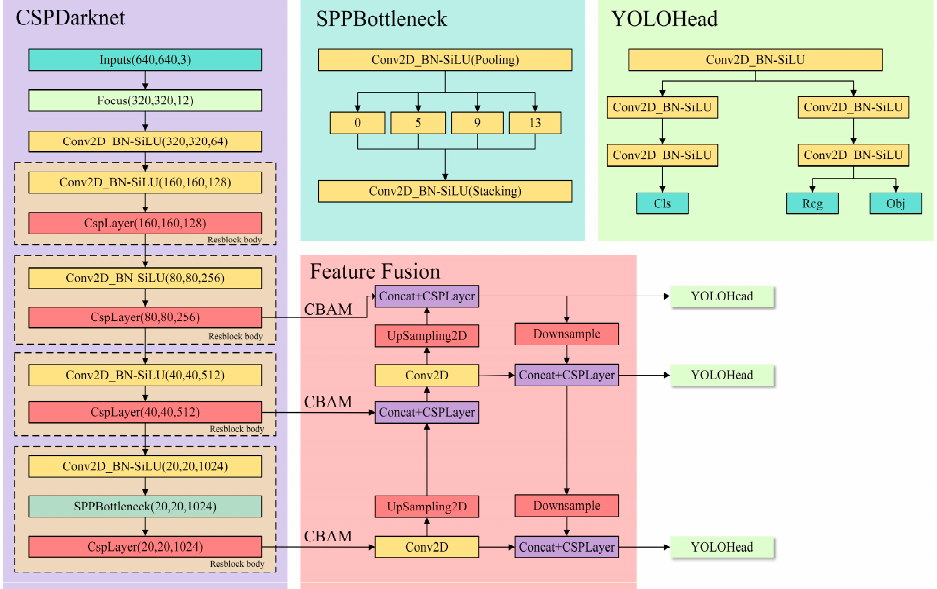
Figure 3. Attention-YOLOX-tiny network structure.